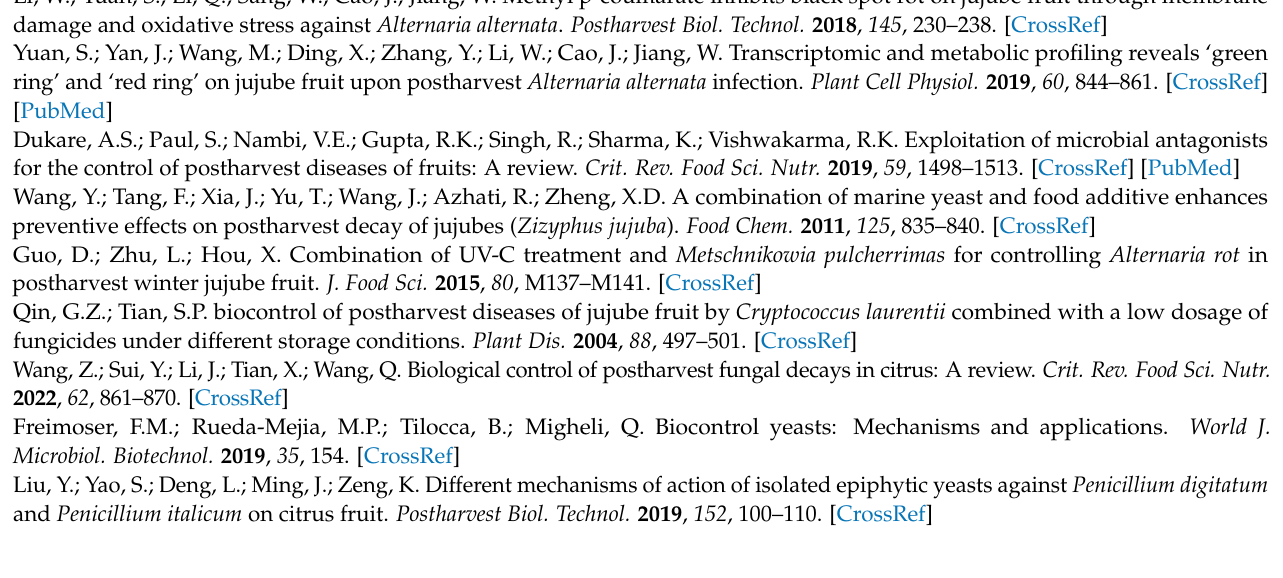
used as a control. A,B: magnification of 1000 × . Figure S2: HPLC analysis of phenylethanol in Figure S3: Pearson’s correlation analysis among Phe, phenylethanol content, biofilm, and disease incidence. Each square color scale represents the correlation coefficient. * indicates significant correlation ( p < 0.05), ** indicates highly significant correlation ( p <